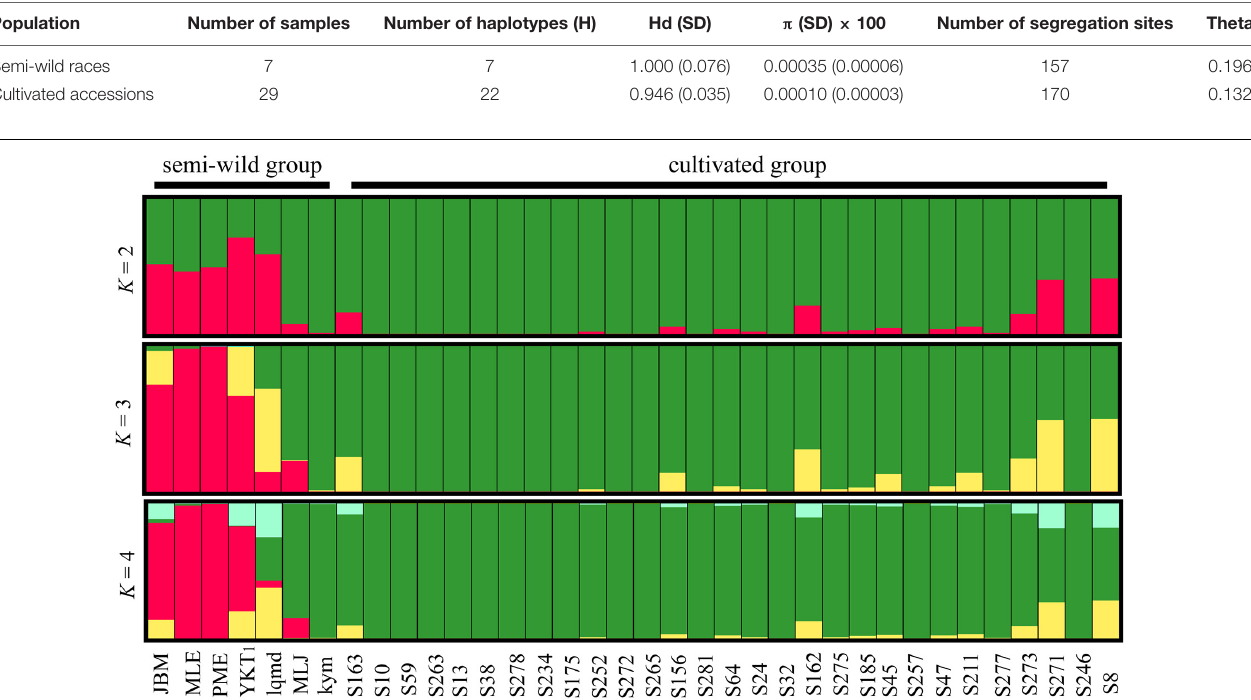
TABLE 4 | Nucleotide diversity and haplotype frequencies for plastid genomes in semi-wild and cultivated accessions of upland cotton.